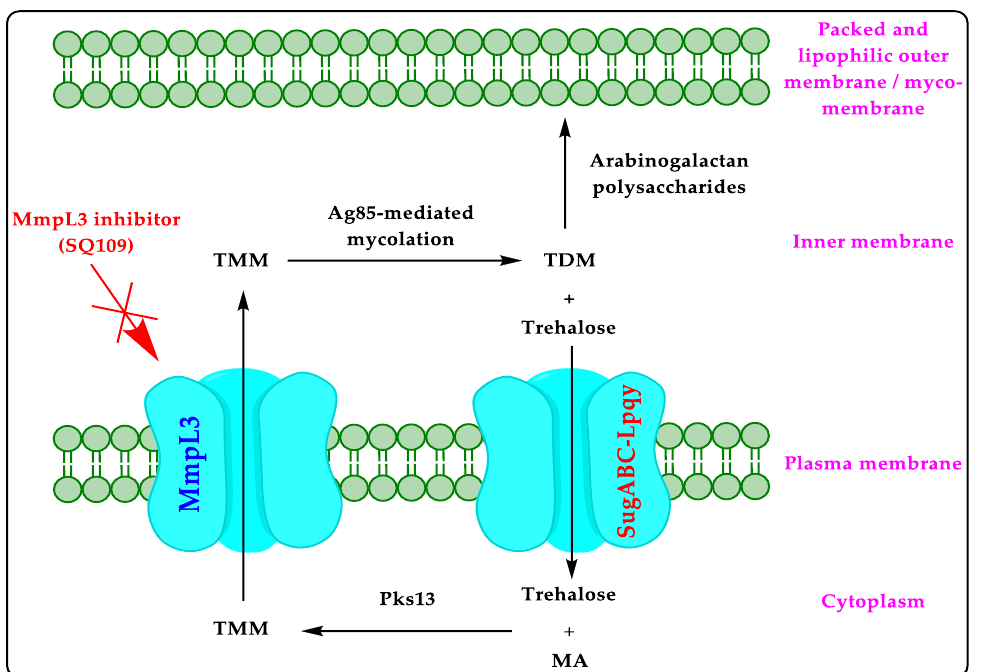
Figure 1. Mechanism of action of MmpL3 inhibitor (SQ109).